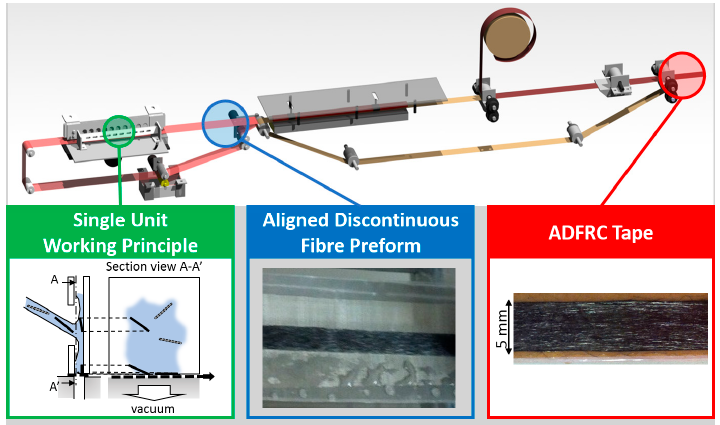
Figure 9. Overview of the HiPerDiF fibre alignment method showing the working principle and dry fibre preform output.